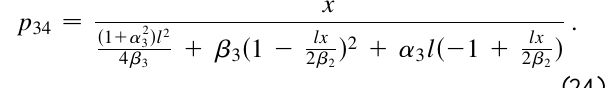
FIG. 6. The flip-flop threshold x th vs the tune n in the case of k , 0 in (20), k (cid:1) 2 0.8 . The flip-flop area lies under the curve.